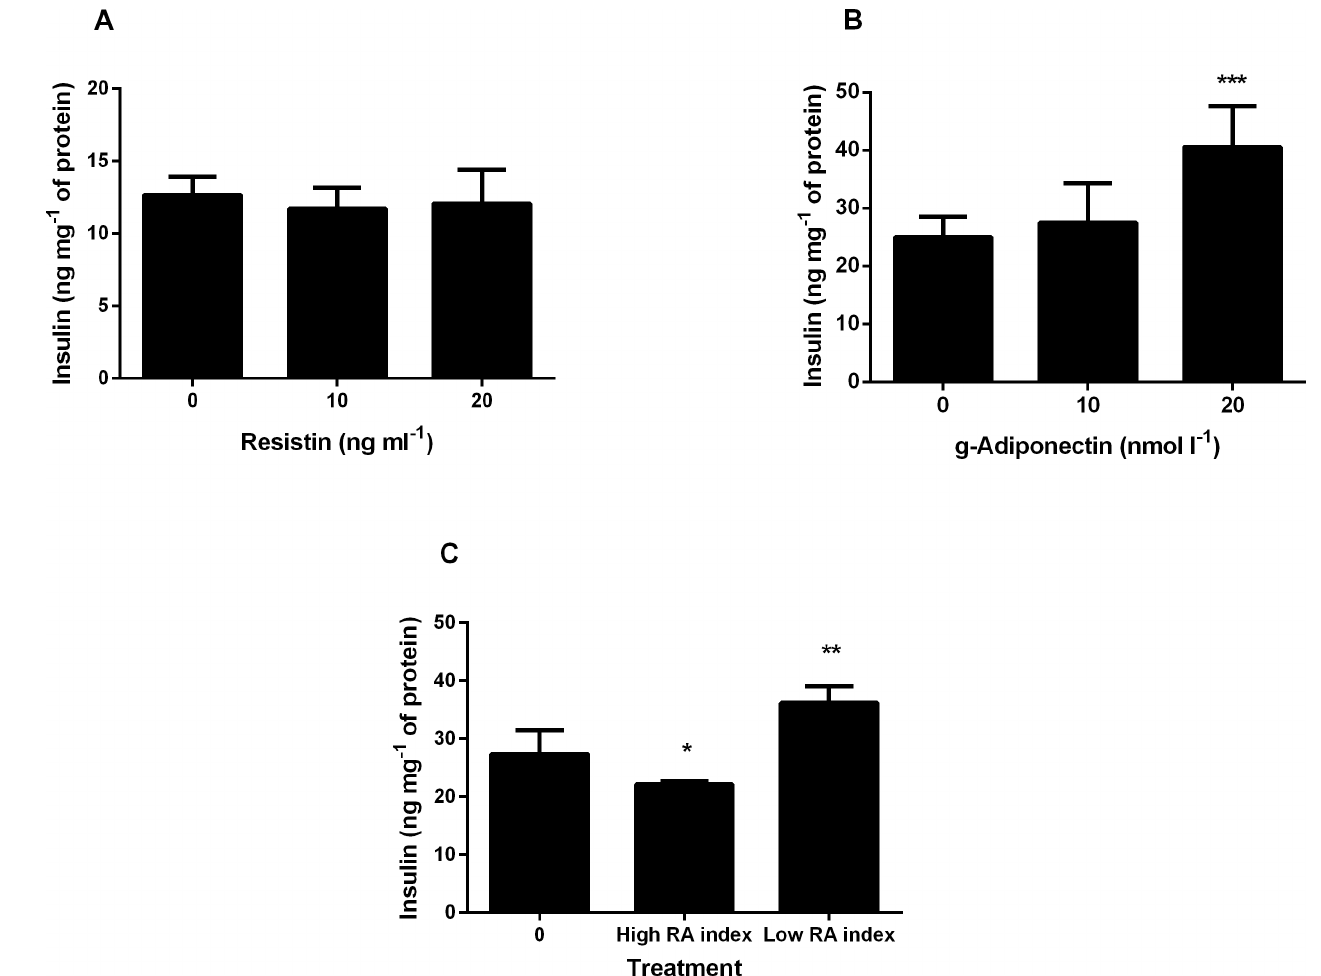
Fig 1. The effect of 24 hour treatment with resistin, g-adiponectin, or both (representing different RA indices) on insulin secretion in BRIN-BD11 cell line. Values are mean ± standard deviation (n = 4). * p < 0.05 ** p < 0.01 *** p < 0.001. ANOVA was applied across groups with post-hoc LSD test for comparison of resistin, g-adiponectin, and high and low RA index with no treatment (control). (A) Cells were incubated for 24 h with 0, 10 and 20ng ml -1 resistin and then stimulated with 16.7mM glucose + 10mM alanine to determine insulin secretion. (B) Cells were incubated for 24 h with 0, 10 and 20nmol l -1 g-adiponectin, and then stimulated with 16.7mM glucose + 10mM alanine to determine insulin secretion. Overall p-value = 0.00003. (C) Cells were incubated for 24 h with no treatment (control), high RA index (20ng ml -1 resistin, 5nmol l -1